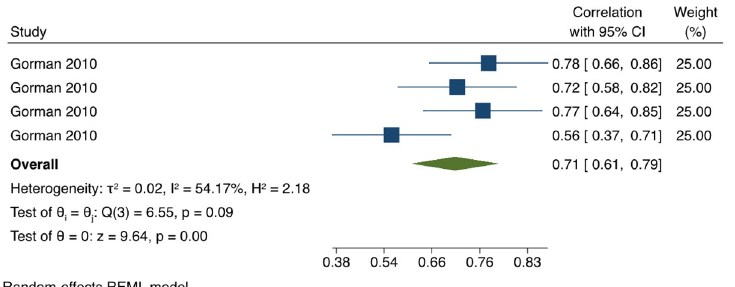
Fig 5. Meta-analysis of Pearson correlation between individual OSCEs stations’ score and total score in physical therapy students. Forest plot presenting the meta-analyzed estimate on Pearson’s r. Each square presents the results of an individual study with the size of the square being proportional to the weights used in the meta-analysis and the horizontal lines indicating the 95% confidence intervals. The solid diamond indicates the overall summary